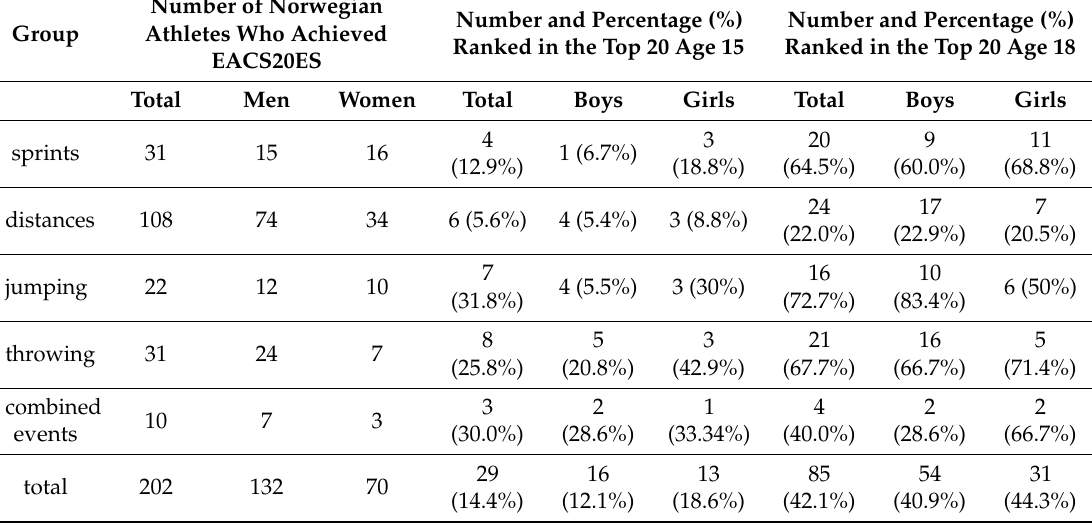
Table 2. The number of Norwegian athletes who achieved the EAC20ES in sprints, distances, jumping, throwing and combined events, and the number and percentage (%) of these ranked among the top 20 in the age groups 15 and 18 years.